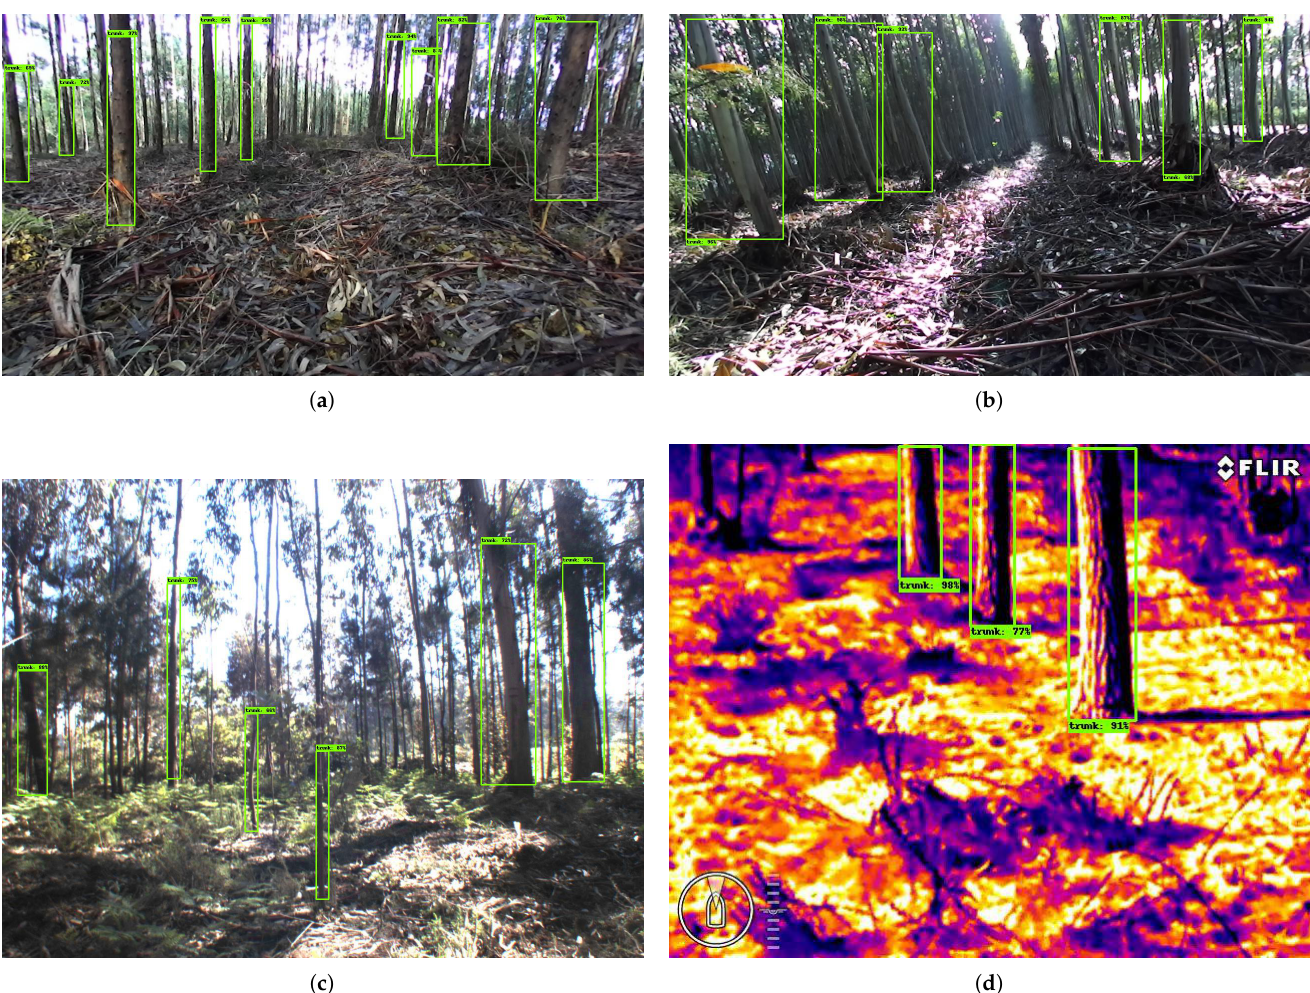
Figure 5. Examples of detection using SSD ResNet50 in ( a – c ) three visible images and ( d ) in one thermal